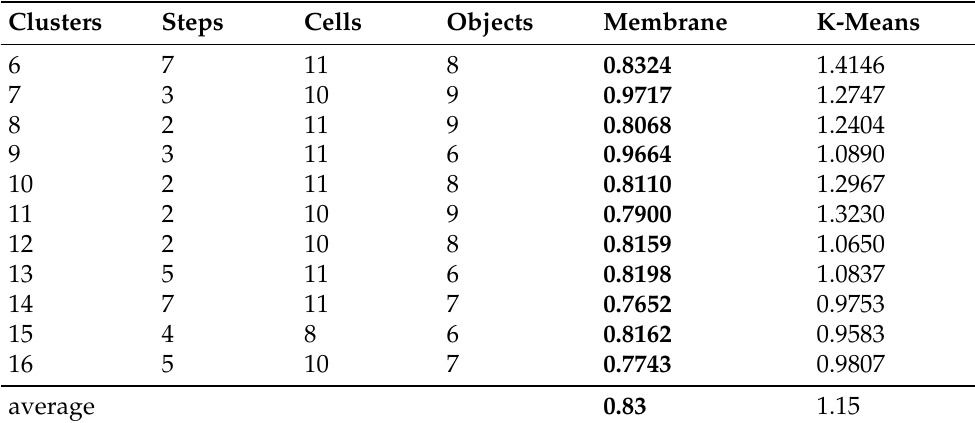
Table 6. Davies–Bouldin scores of the K-Means and the Membrane clustering with the different number of clusters and m-gram size of 11 and using different membrane configurations. The Better scores are bold in the